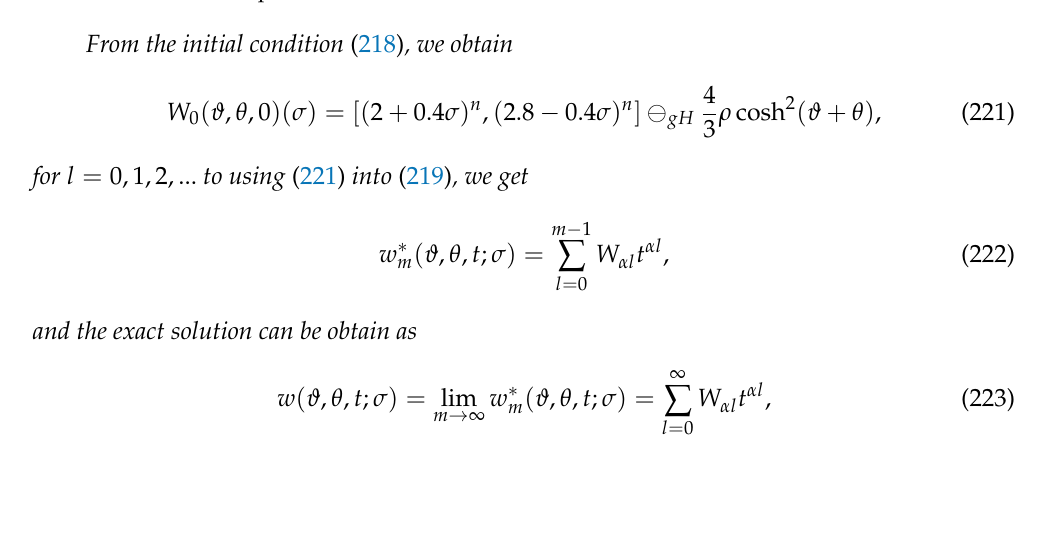
Figure 3. Comparison of exact and approximate solution of fuzzy fractional wave-like equation for ϑ = 0.02, θ = 0.002, φ = 0.03, t = 0.007, n = 5. ( a ) 2 D figure for the comparison of exact and approximate solutions of w in Example 7. ( b ) 3 D figure for the comparison of exact and approximate solutions of w in Example